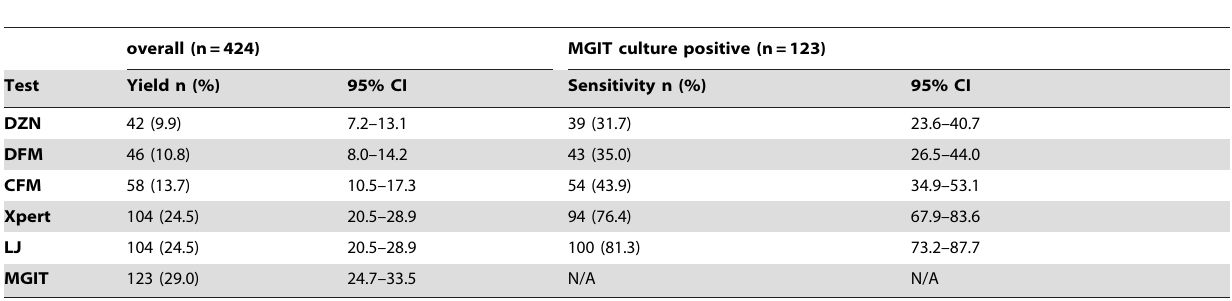
Table 3. Overall yield and sensitivity using MGIT as the reference comparator, for each of the test methods.